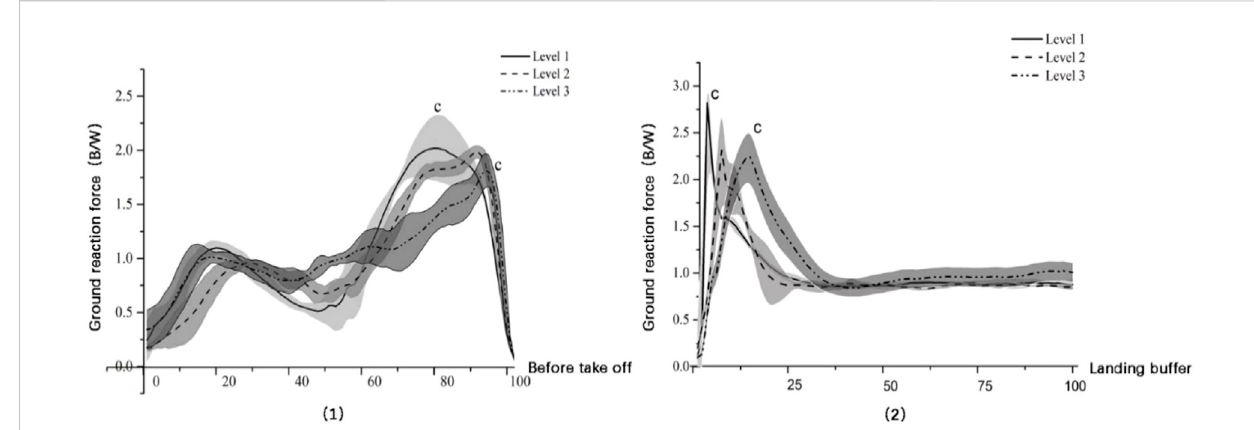
FIGURE 6 FUS ’ s GRF variations in take-off (Right) and landing (Left) phases.